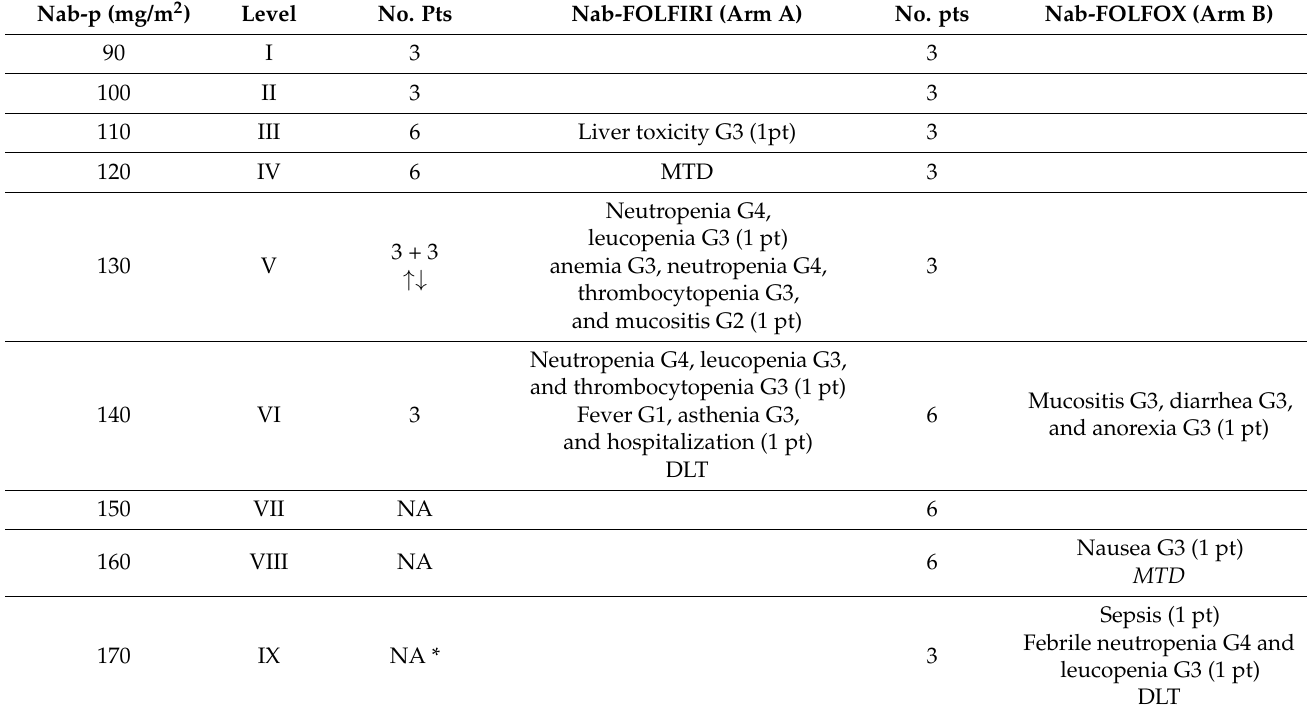
Table 2. Phase I: dose escalation and DLTs.